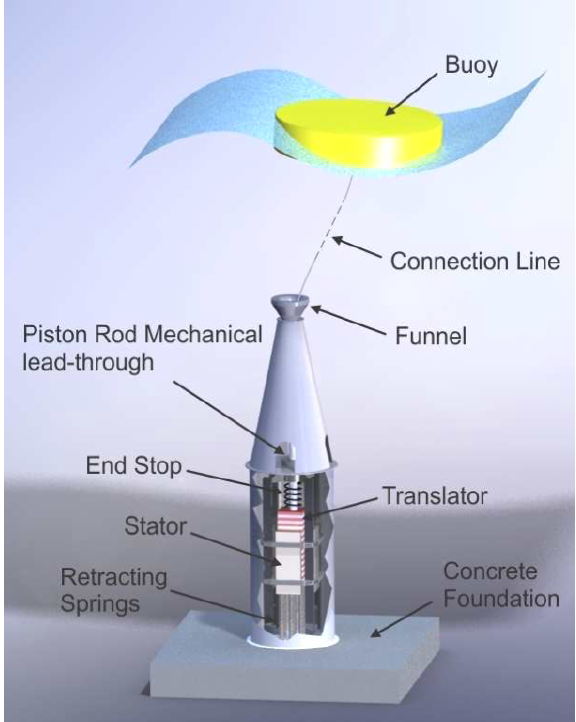
Figure 5. Schematic of Uppsala University (UU)’s WEC. Reproduced with permission from